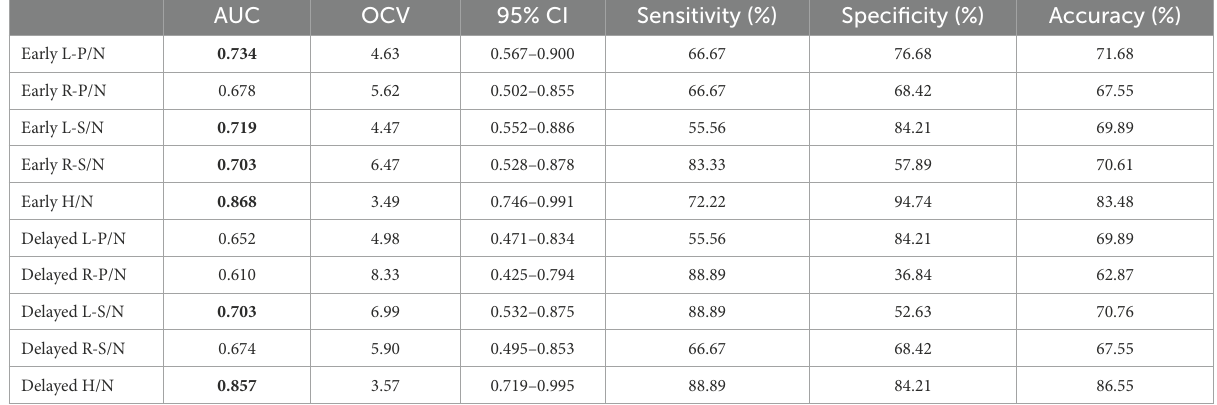
TABLE 2 Measures of diagnostic accuracy of salivary gland and myocardial MIBG scintigraphy in differentiating PD and NPD. AUC OCV 95% CI Sensitivity (%) Specificity